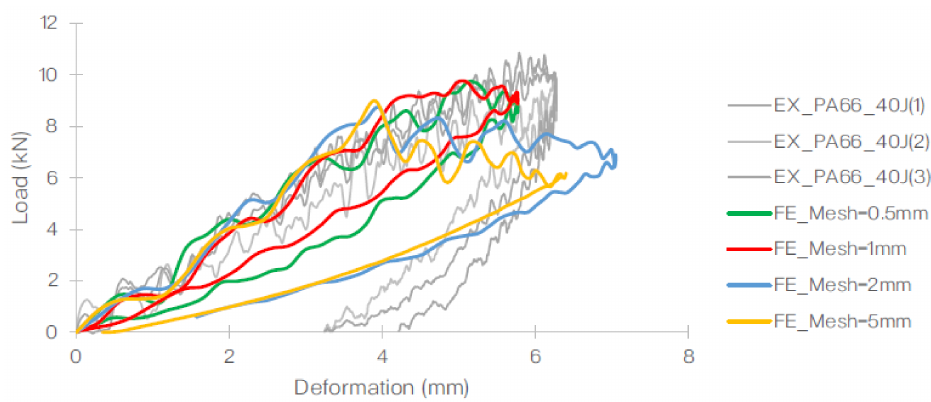
Figure 13. Comparison of the load–displacement curve obtained from the FE for the 40 J impact event conducted using different mesh sizes against the experiment [28].